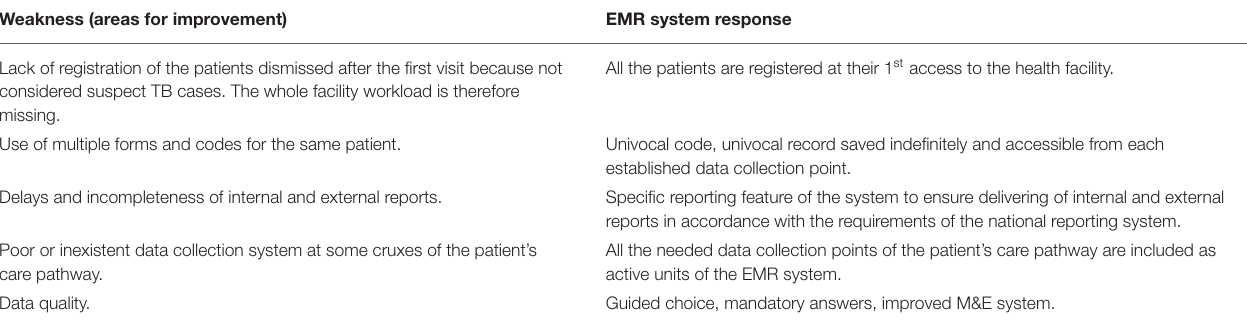
TABLE 2 | Examples of indicators of weaknesses in the current data collection system and the correspondent EMR system response. Weakness (areas for